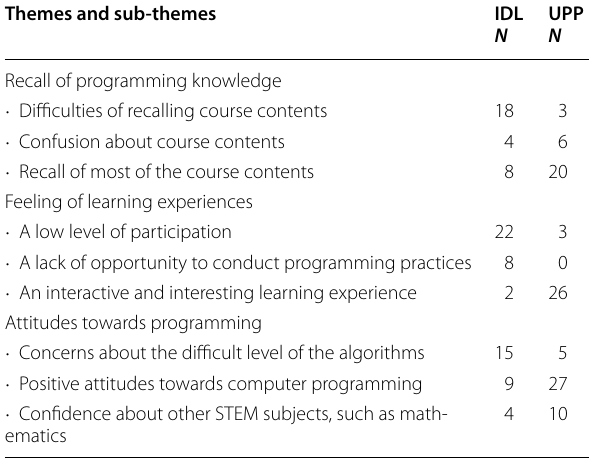
Table 5 Themes extracted from semi-interviews in